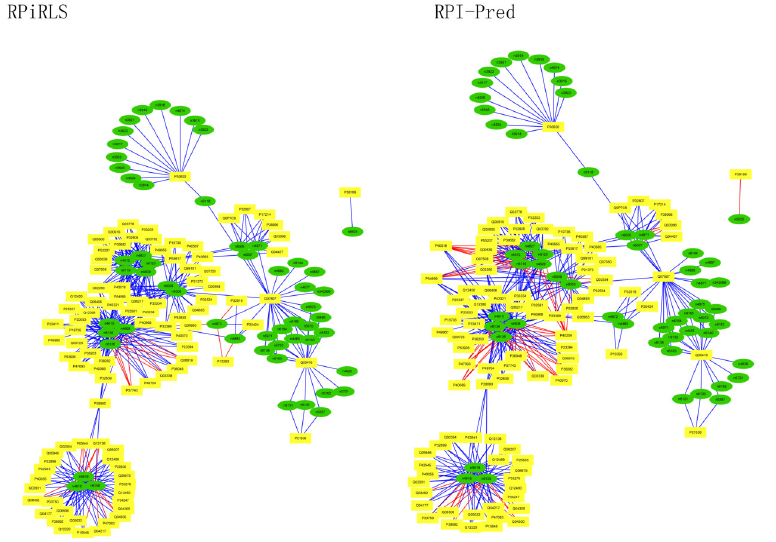
Figure 5. Comparison of the long non-coding RNA-protein interaction networks predicted by the RPiRLS and RPI-Pred methods, for Saccharomyces cerevisiae